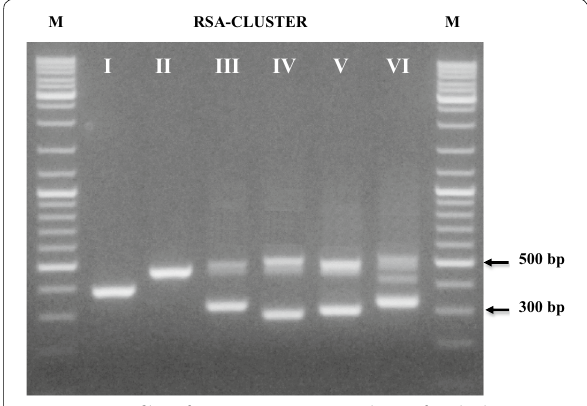
Fig. 1 RSA profiles of representative LAB isolates of each cluster obtained. M: DNA ladder